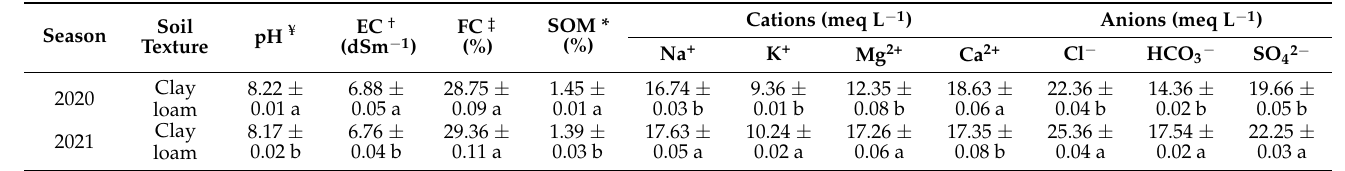
Table 4. Physicochemical traits of the surface layer (0–30 cm) of the experimental soil during the 2020 and 2021